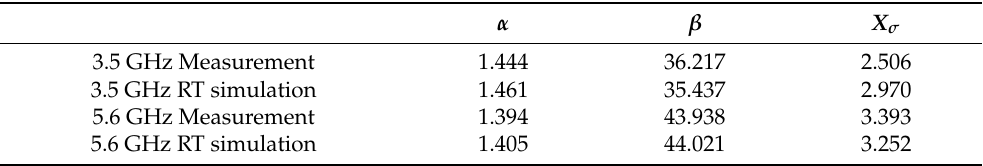
Table 3. Path-loss model parameters at 3.5 GHz and 5.6 GHz